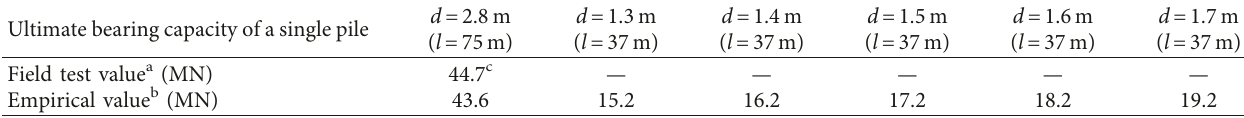
Table 5: Ultimate bearing capacity of single piles with different pile diameters and